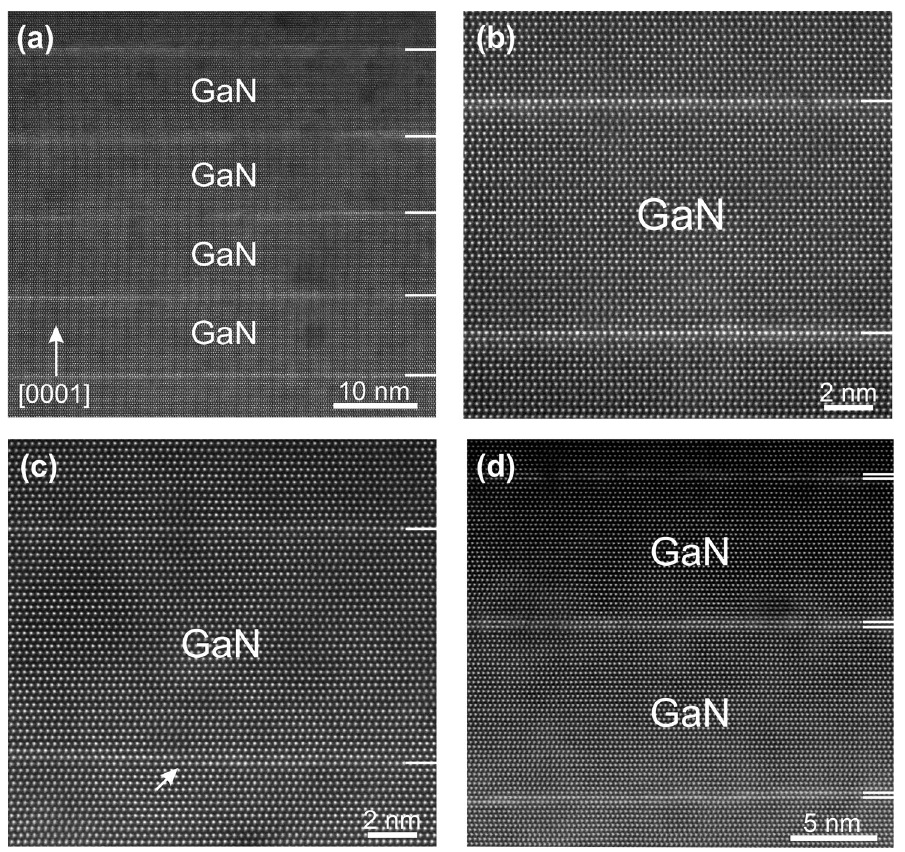
Figure 2. Cross-sectional HRSTEM images of the MQW heterostructures recorded along the [ 1120 ] zone axis. ( a ) Representative overall image obtained from sample A3 showing the good periodicity of the MQW. ( b–d ) Atomic resolution HAADF-HRSTEM images of samples A3, A4, B3 respectively. In series A, 1 ML-thick QWs are observed and, in series B, 2 ML-thick QWs are formed. The tilted arrow in ( c ) indicates a step of the